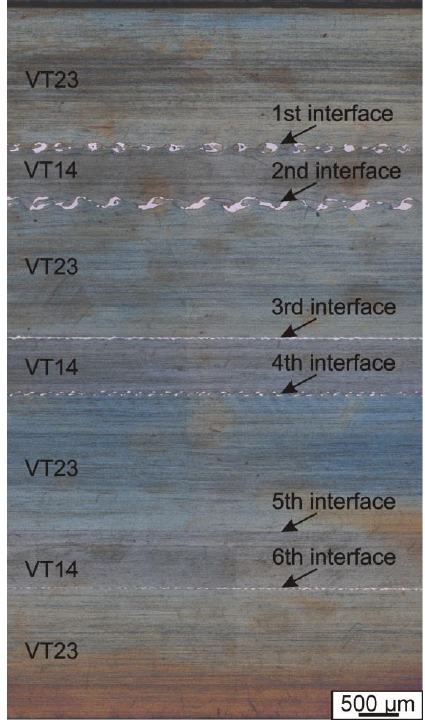
Figure 2. Panoramic view of the composite cross section.